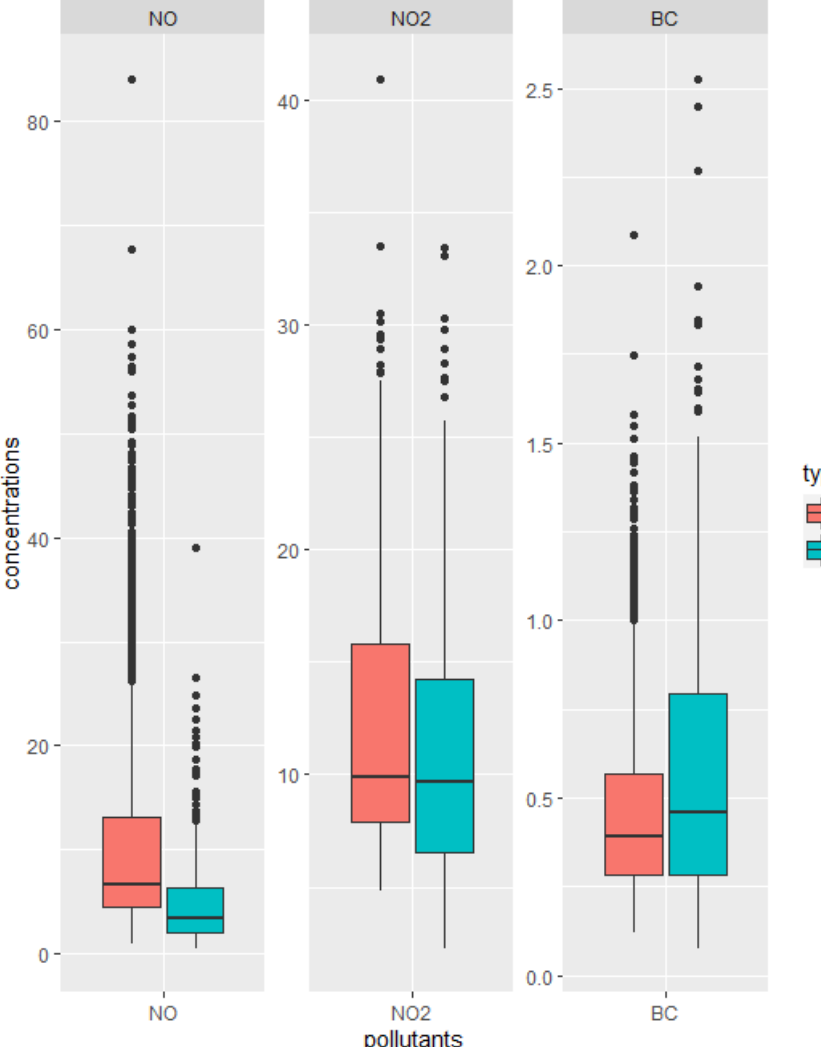
Figure 5. Pollutant distributions’ comparison between our work and one stationary monitor (NO and NO 2 are in the unit of ppb, BC is in the unit of µg/m 3 ).